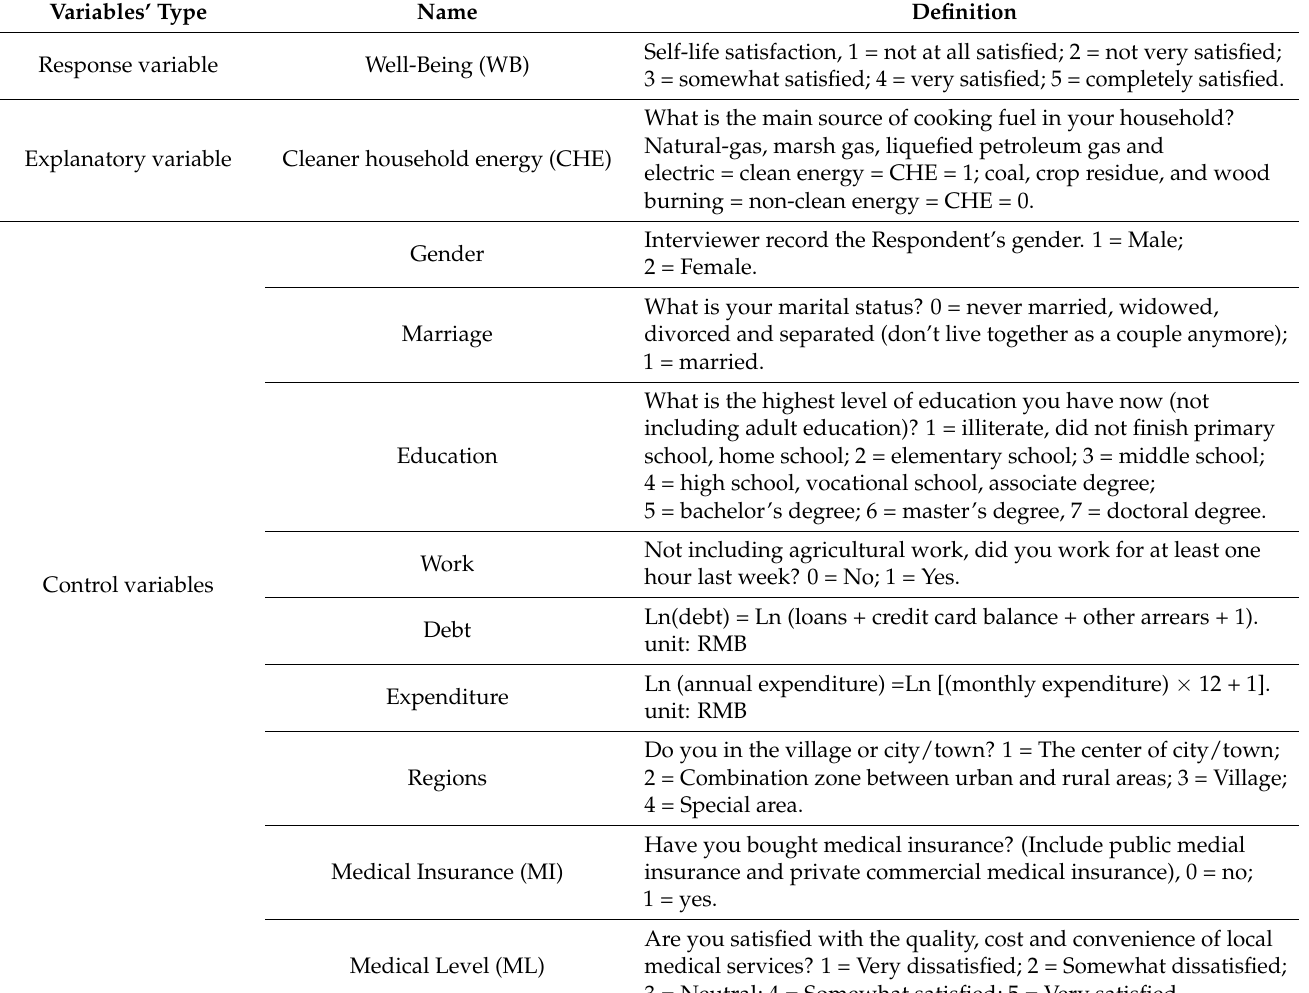
Table 1. Variable’s selection and